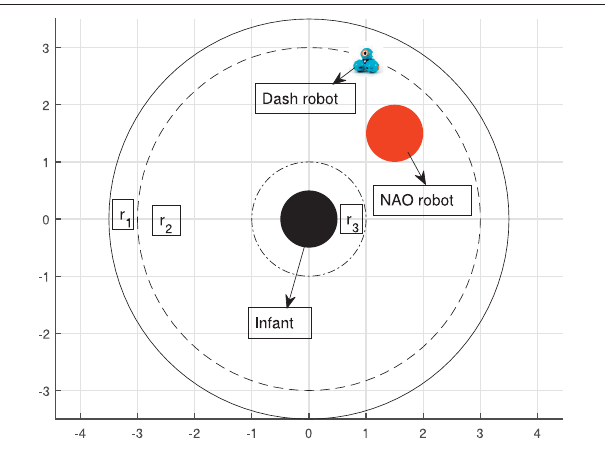
FIGURE 6 | Schematic of DAS h ’ s robot